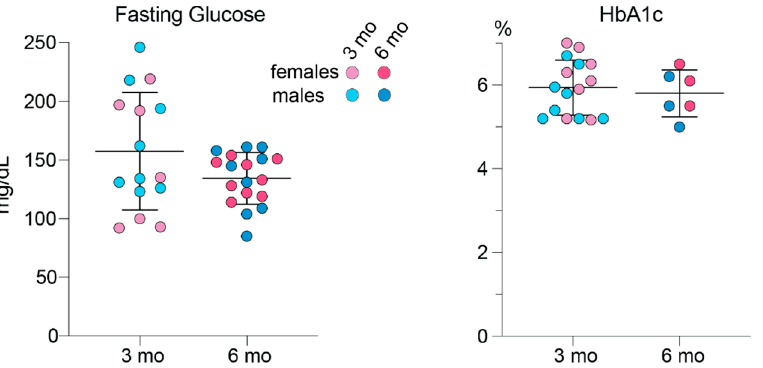
Figure 6. Blood glucose and glycemic control (HbA1C) in hamsters. The measurements were taken in individual animals: 3-month-old (3 mo) 7 females and 8 males for fasting glucose and 8 females and 8 males for hemoglobin A1c (HbA1c); and 6-month-old (6 mo) 9 females and 9 males for fasting glucose and 3 females and 3 males for HbA1c. Data represent the mean ± SD. No sex-based differences were detected, hence data from female and male animals were combined. No age differences were detected either.